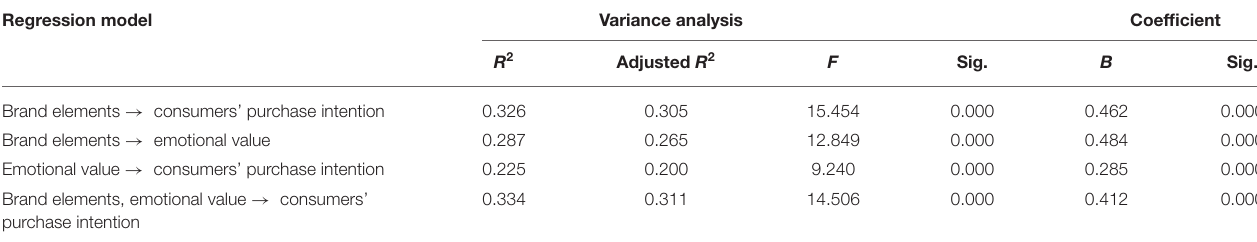
TABLE 12 | Intermediary role played by the emotional